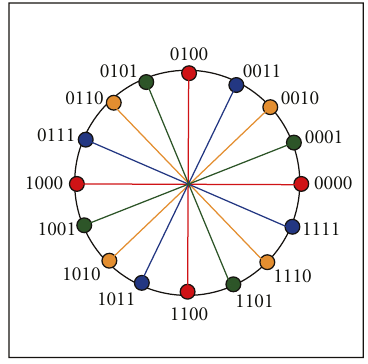
Figure 5: Bit labeling with equally spaced candidate signal points for any combinations of nonshaping bits. (The shaping bits choose